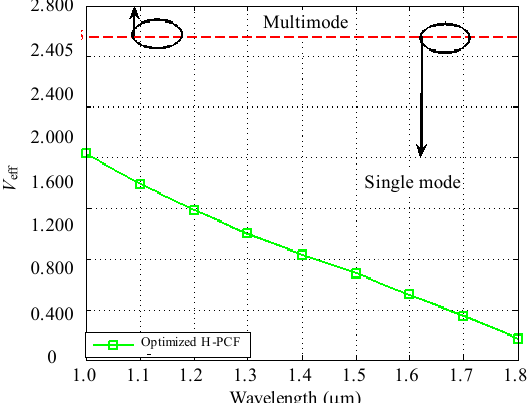
Fig. 10 V parameter of the proposed H-PCF as a function of wavelength for  = 3.00  m,  c = 1.08  m, d = 2.85  m, d c = 0.774  m, and d c 0 = 1.08 